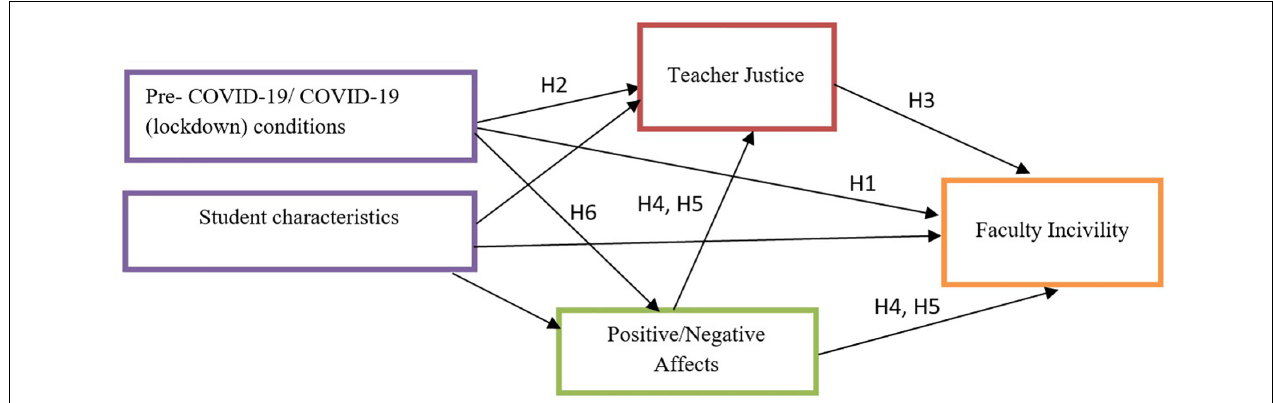
FIGURE 1 | Model 1: The theoretical structure of the proposed